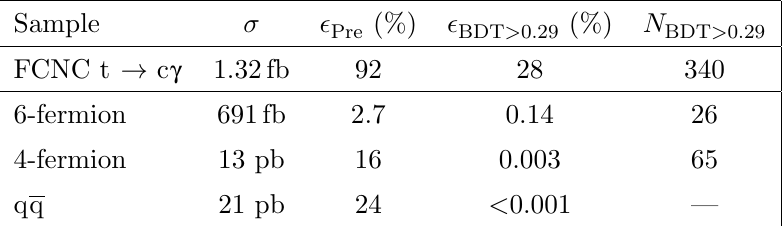
Table 14. Cross section values, selection e(cid:14)ciencies and numbers of events expected for signal and background processes in the analysis searching for FCNC decay t ! c g at CLIC at 380 GeV. Num- bers of events correspond to a luminosity of 1.0 ab (cid:0) 1 , assuming unpolarised beams, and BR(t ! c g ) = 10 (cid:0) 3 for signal